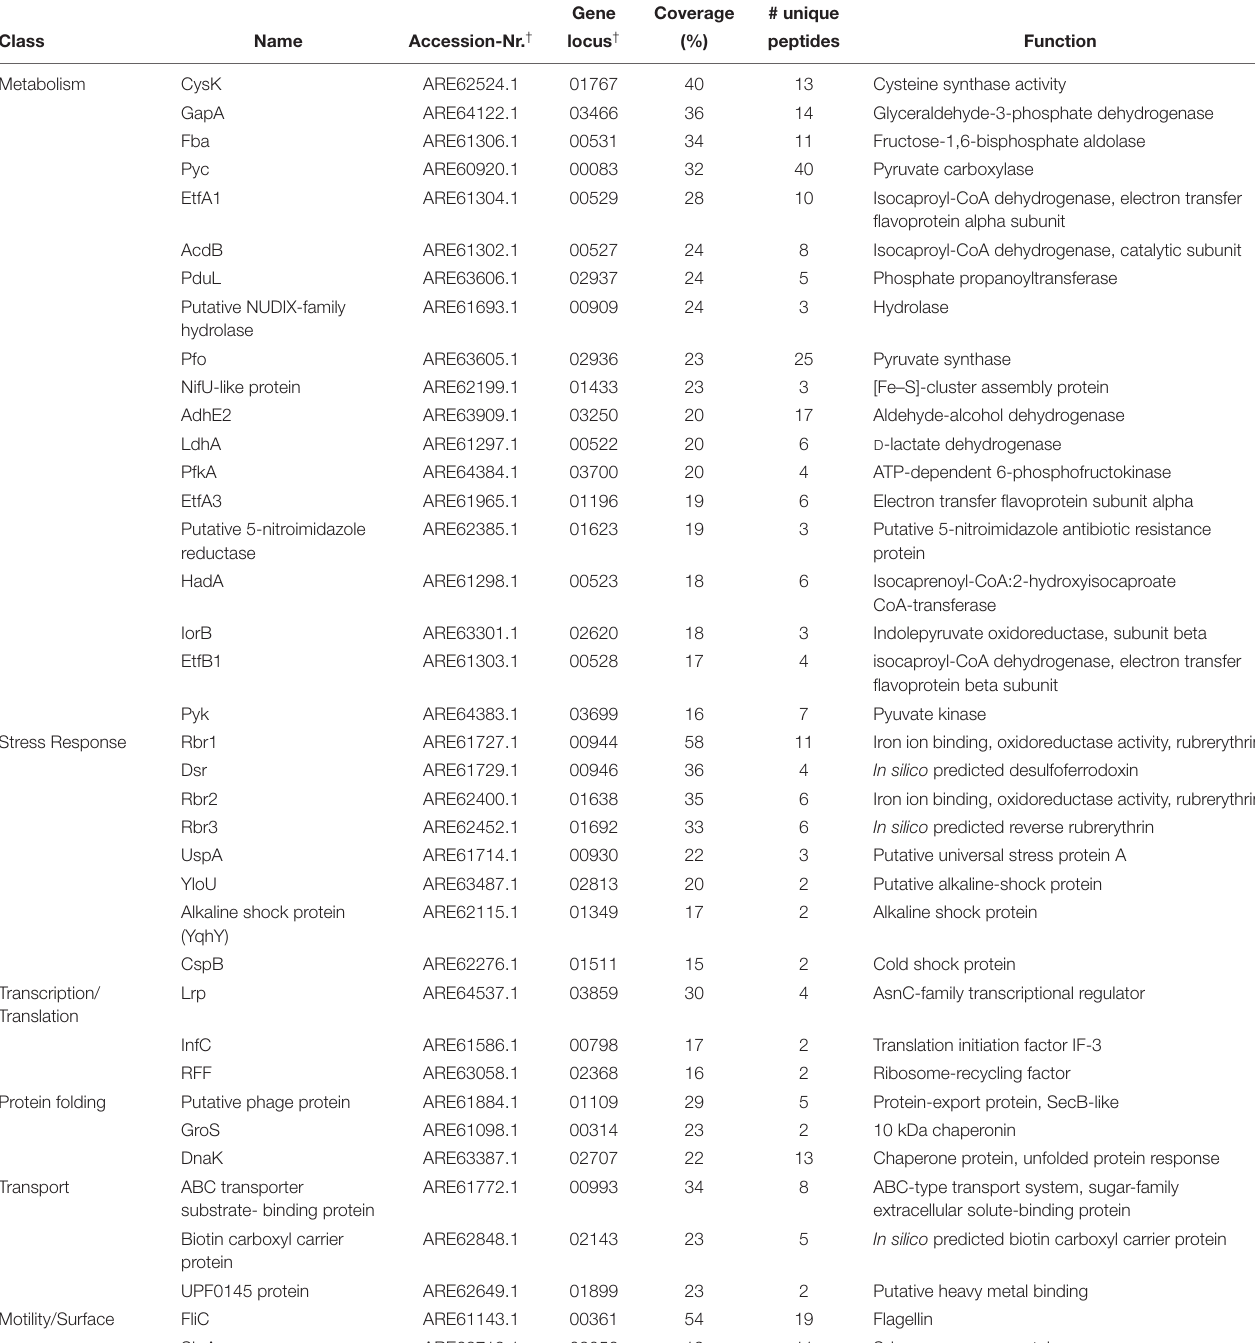
TABLE 3 | Putative interaction partners of CdPpiB identified by in vivo cross-linking.